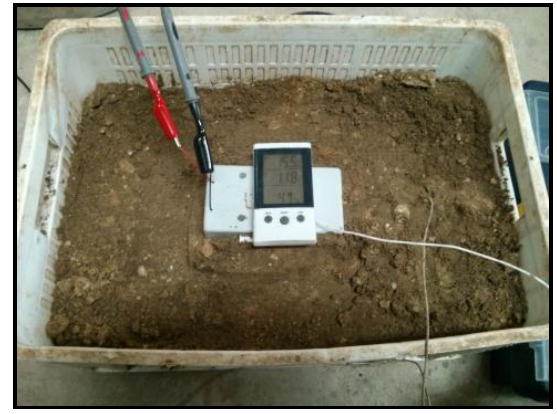
Figure 10. Peltier cell installed inside a plastic case and buried in the sand.